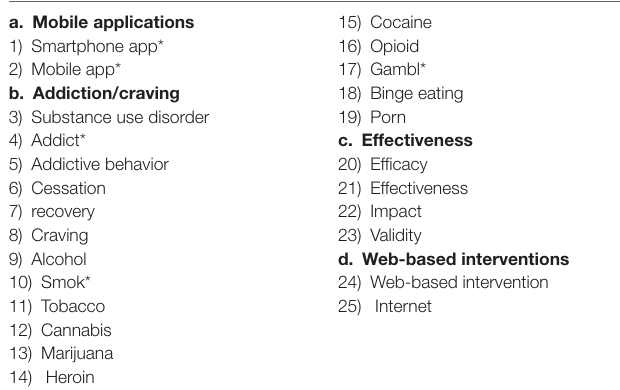
TABLE 1 | MESH terms used for database